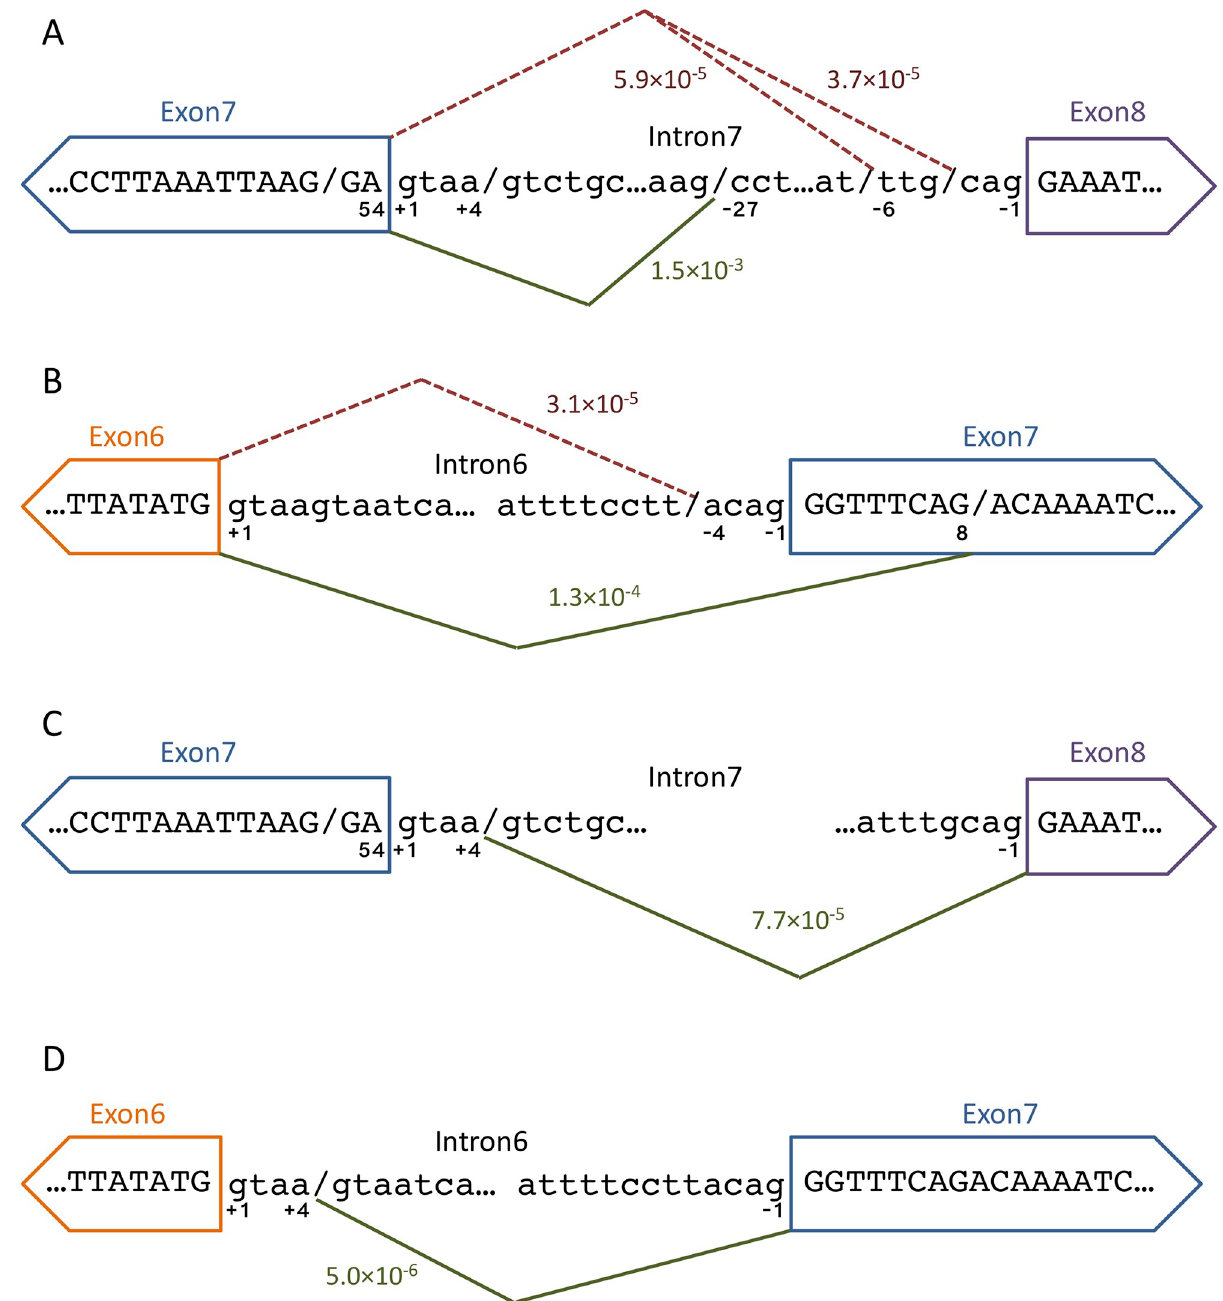
Fig 4. Non-canonical splice site usage. A) Non-canonical 3’SS usage between exon 7 and exon 8. The green line represents the unannotated non- canonical 3’ SS event 27 nucleotides upstream of the canonical intron7|exon8 junction. The red dashed line represents the non-canonical splicing observed that is due to transcription or library generation errors resulting in canonical AG dinucleotide sequences. B) Non-canonical 3’ SS usage between exon 6 and exon 7. The green line represents the unannotated non-canonical 5’ SS event at position 8 in exon 7. The red dashed line represents the non-canonical splicing observed that is due to transcription or library generation errors. C) Non-canonical 5’ SS usage between exon 7 and exon 8. The green line represents the usage of the intrinsic non-canonical 5’ SS. D) Non-canonical 5’ SS usage between exon 6 and exon 7. The green line represents the usage of the intrinsic non-canonical 5’